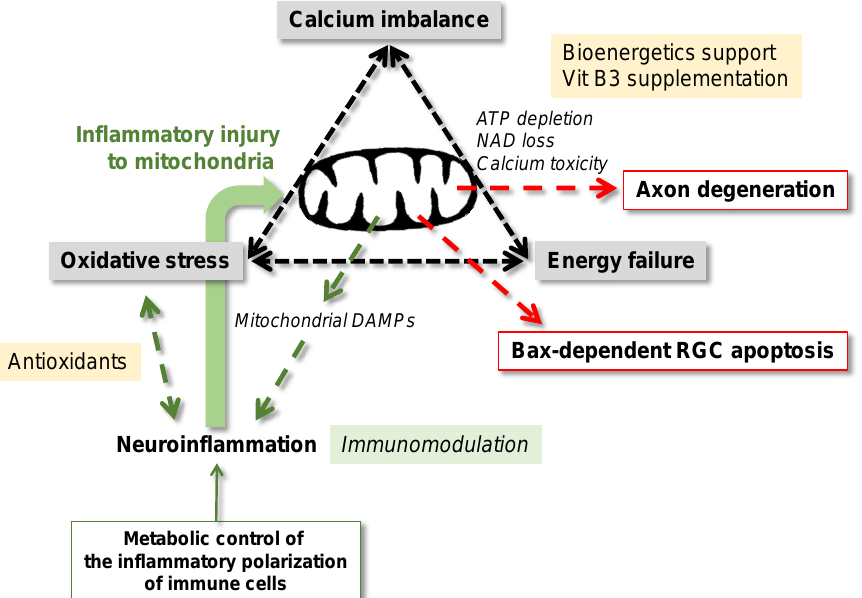
Figure 4. Interplay between mitochondrial dysfunction and neuroinflammation in glaucoma. Mito- chondria through energy failure, oxidative stress, disturbed calcium homeostasis, and nicotinamide adenine dinucleotide (NAD) loss are critically involved in RGC degeneration and neuroinflamma- tion. Mitochondria-generated oxidative stress and the mitochondrial constituents released after increased membrane permeability, including damage-associated molecular patterns (DAMPs), can induce glial inflammatory responses. Mitochondria’s role in neuroinflammation also includes the metabolic control of glial inflammatory polarization. While dysfunctional mitochondria induce neuroinflammation, proinflammatory cytokines may further impair mitochondria. Yellow boxes indicate the related treatment strategies that are being tested in clinical studies. As shown in the green box, immunomodulatory treatments are still explored in preclinical